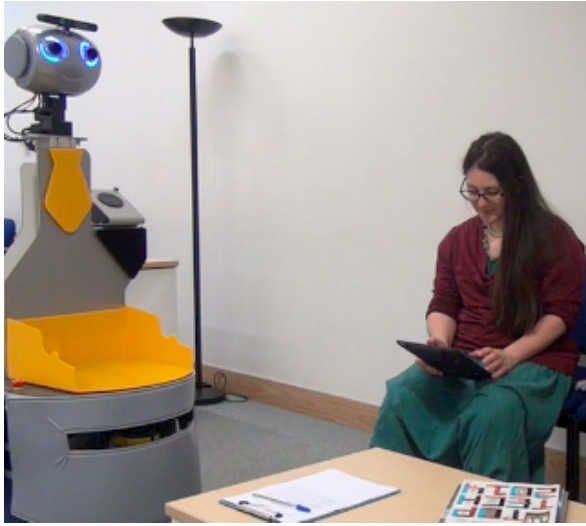
Figure 1: A participant and the robot in the experimental